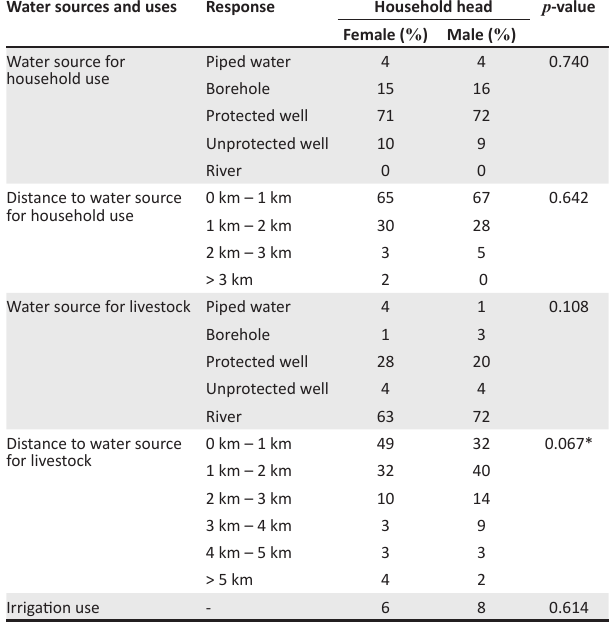
TABLE 1: Water sources for household use, livestock and crops. Water sources and uses